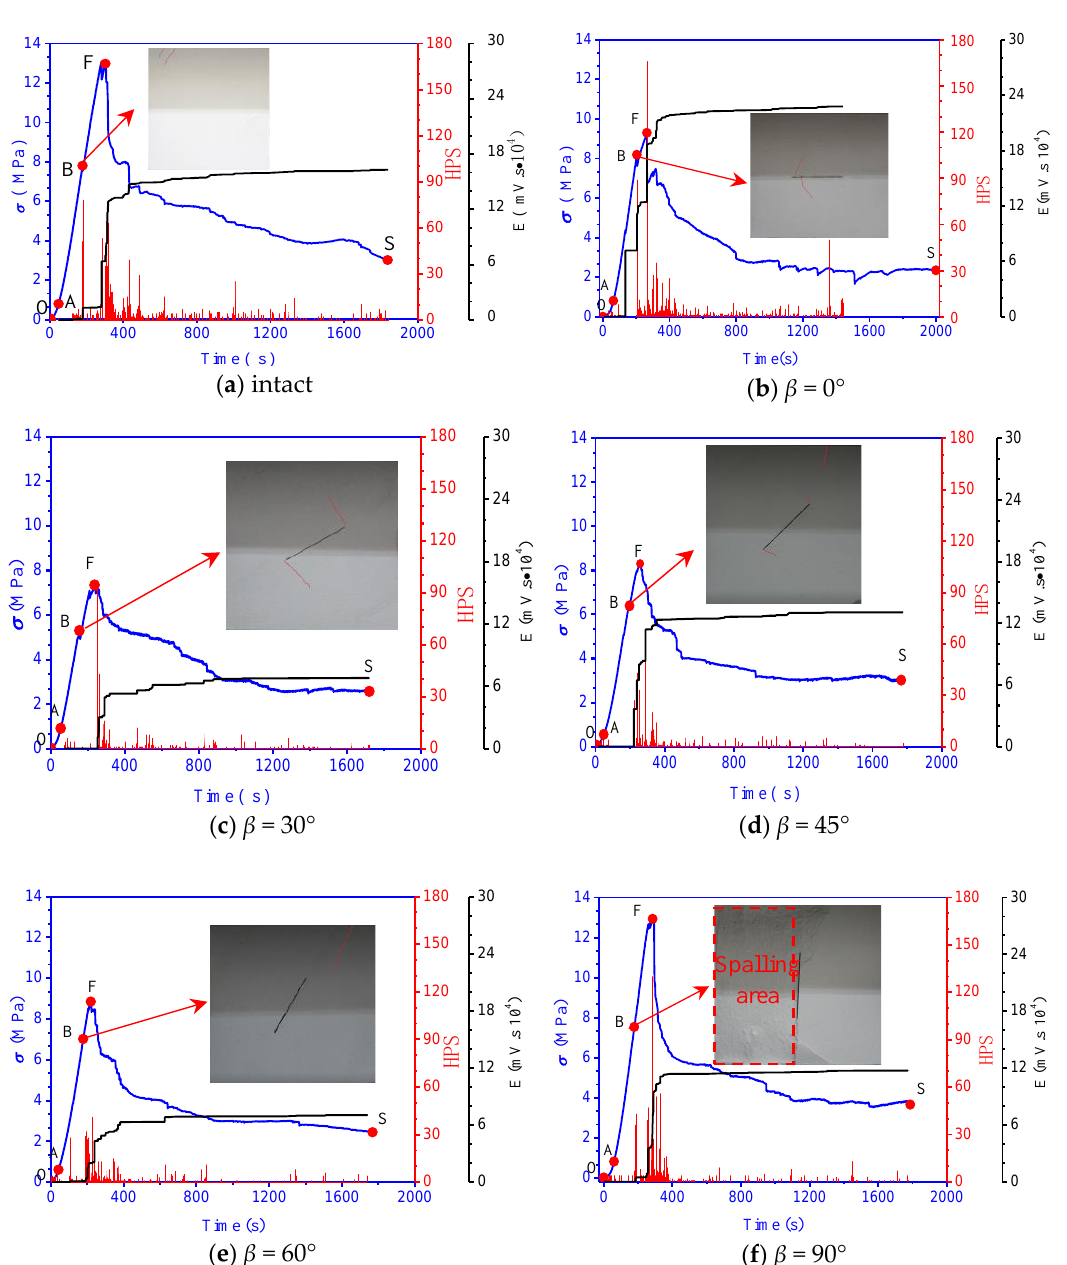
Figure 3. The variations in the stress, hits per second (HPS), and energy accumulation over time for samples with different inclination angles.